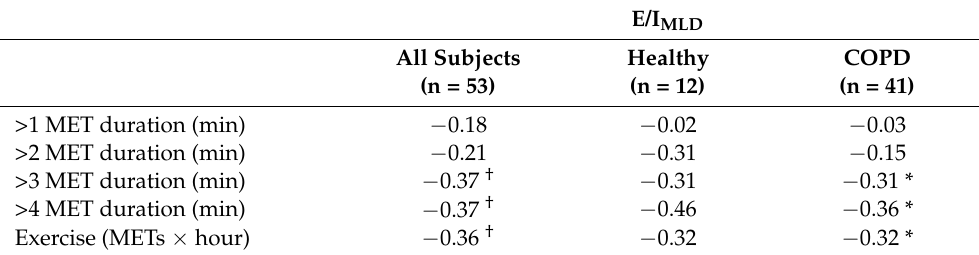
Figure 2. Correlations between EX and E/I MLD values for healthy subjects and patients with COPD. □, healthy subjects; ●, patients with COPD. Definition of abbreviations: COPD, chronic obstructive pulmonary disease; METs, metabolic equivalents; EX, exercise (METs × hour); E/I MLD , expiratory to inspiratory ratio of the mean lung density. Table 2. Coefficients of correlation between exercise intensity and E/I MLD for healthy subjects and patients with COPD.